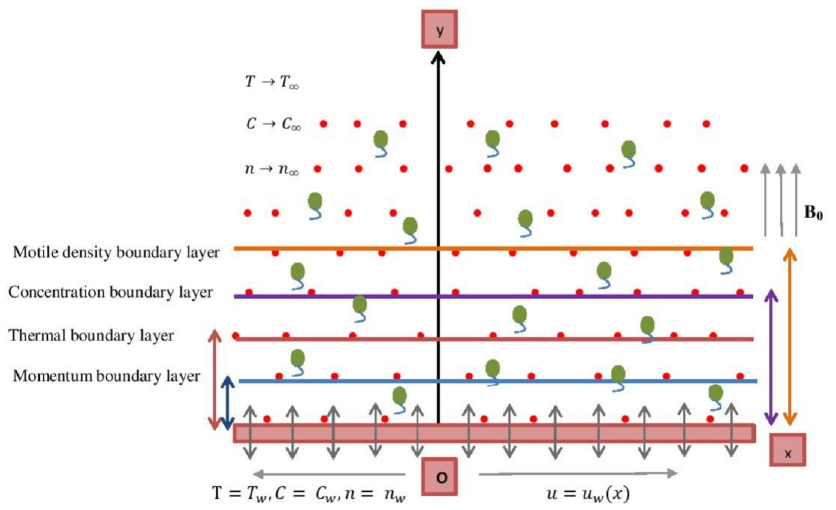
Figure 1. Flowchart of the elongated